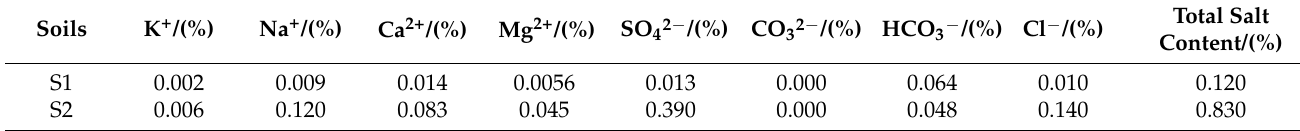
Table 1. Soil salt content in the different soils in the study site (%).